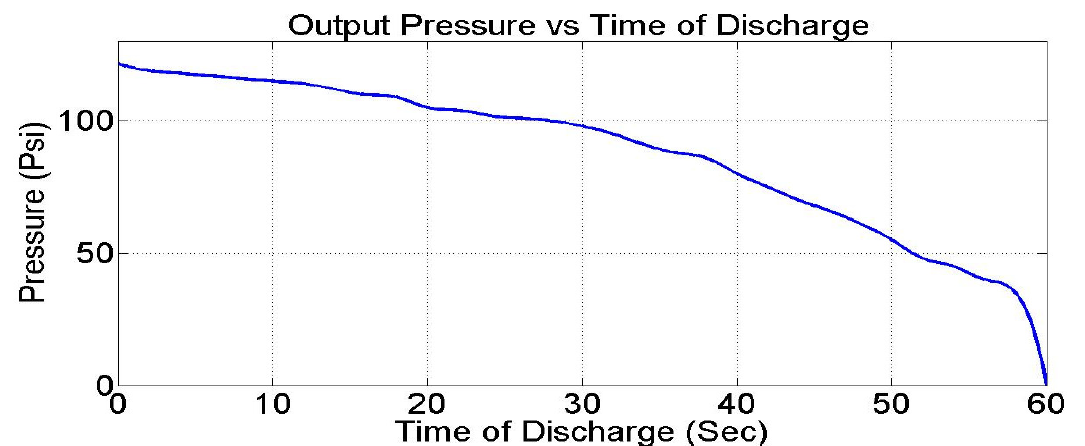
FIG 7: OUTPUT RESPONSE VS TIME OF DISCHARGE